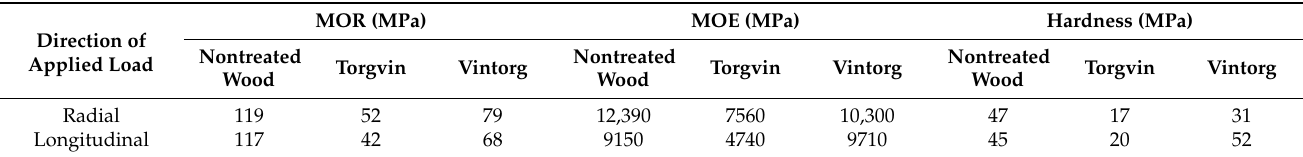
Table 10. Vintorg strength properties found by